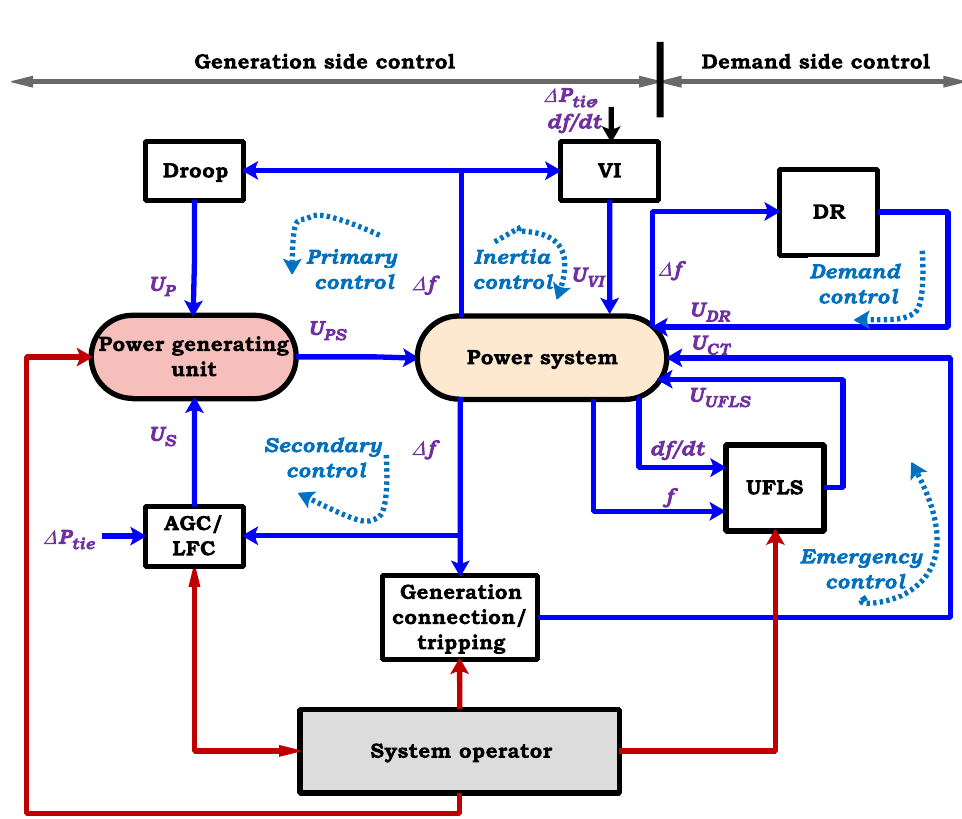
Figure 7. Updated frequency control scheme in modern power